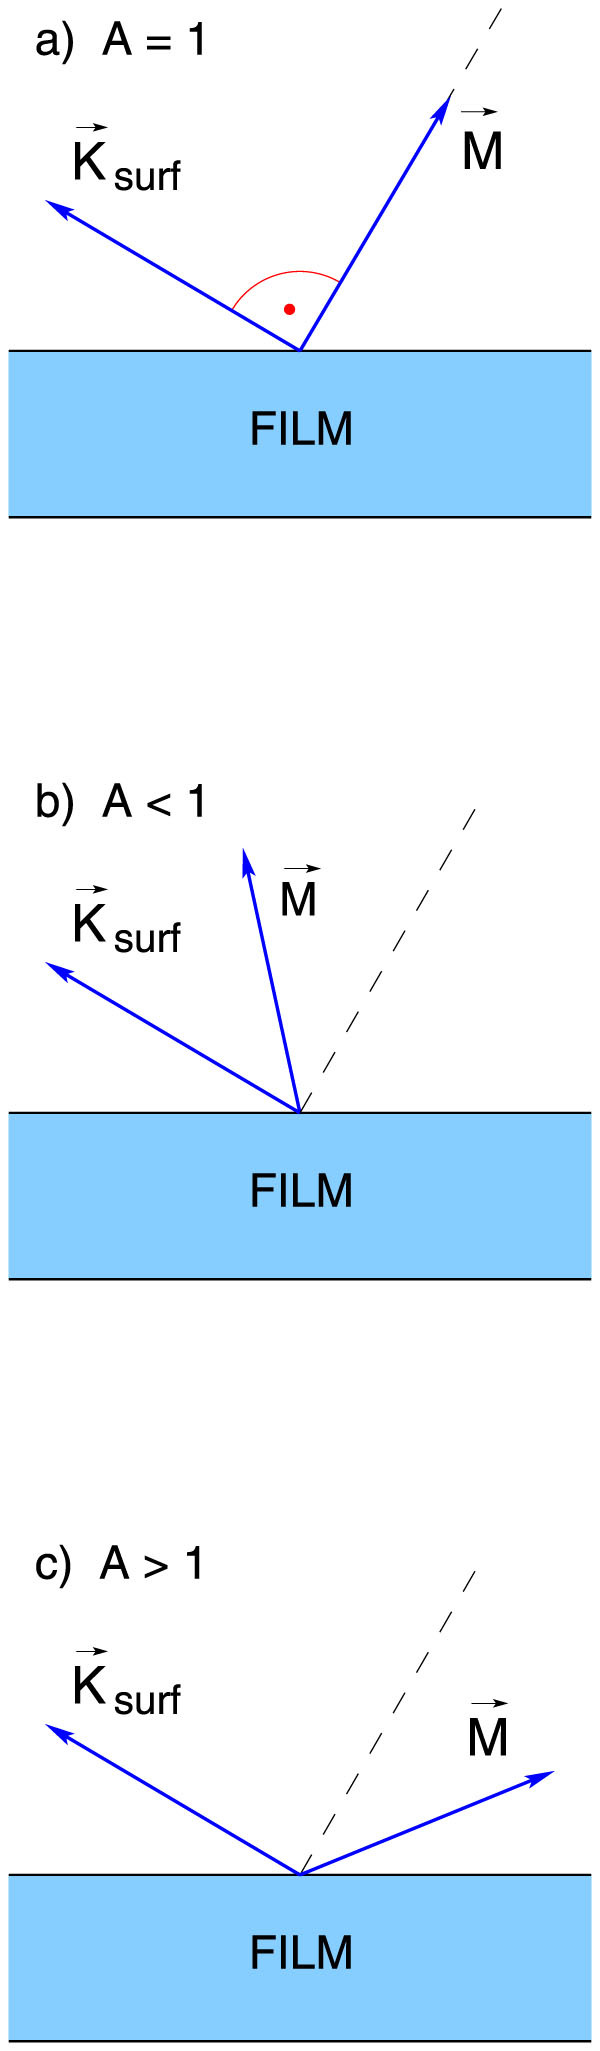
Schematic representation of three surface spin pinning regimes which prevail in a thin film depending on the configuration of its magnetization M with respect to the effective surface anisotropy field Ksurf (see (2)).When aligned as in (a), the surface spins do not feel the anisotropy field and A = 1, which corresponds to their natural freedom. In the configurations (b) and (c) the surface spins are pinned (A < 1) and unpinned (A > 1), respectively, due to the anisotropy field.